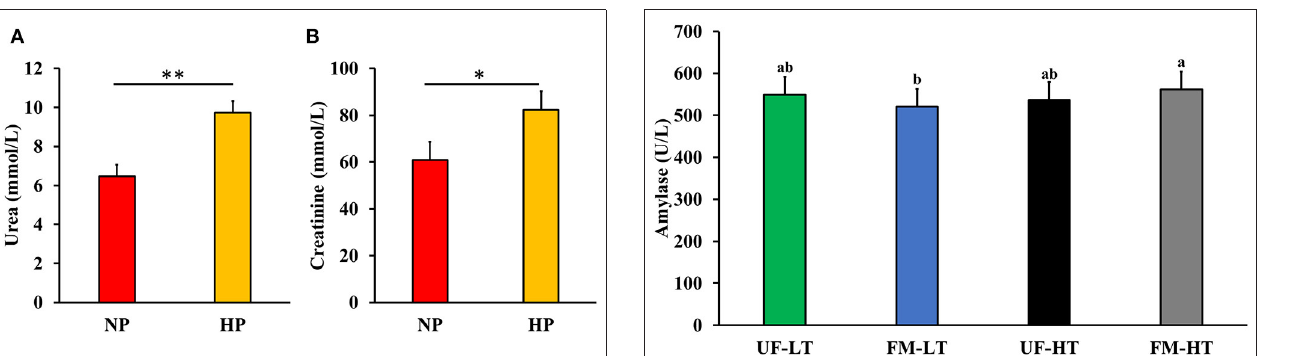
FIGURE 4 | Blood amylase content in dogs fed either low (LT) or high (HT) tannin fava bean–based diets without (UN) or with (FM) fermentation. From weeks 2 to 5, using a randomized, crossover, 2 × 2 Latin square design, 8 mixed-gender, neutered beagles were fed 4 diets differing in fava bean variety and fermentation as follows: UF-HT, FM-HT, UF-LT, and FM-LT. Bars with no common letter (a, b) differ significantly ( P < 0.05). There was no effect of dietary protein content on serum amylase content ( P >